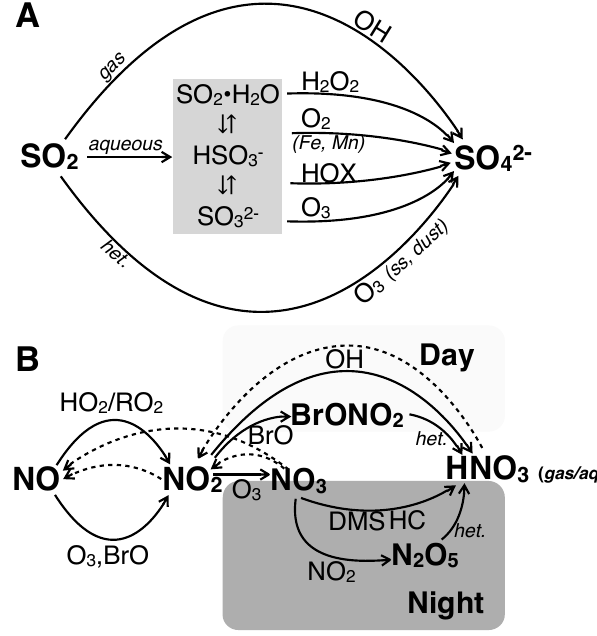
Figure 1. Summary of major (A) sulfate production pathways and (B) nitrate production pathways. “HOX” = HOBr or HOCl; “ss” = sea salt; “het.” = heterogeneous reactions on the surface of aerosols. HNO 3 formed through the heterogeneous reactions is formed in the aqueous phase, while the other pathways produce gas-phase HNO 3 . HNO 3 partitions between gas and aqueous phases based on aerosol thermodynamics. Aqueous-phase HNO 3 may dis- sociate into H + + NO 3 − . Dashed lines indicate photolysis